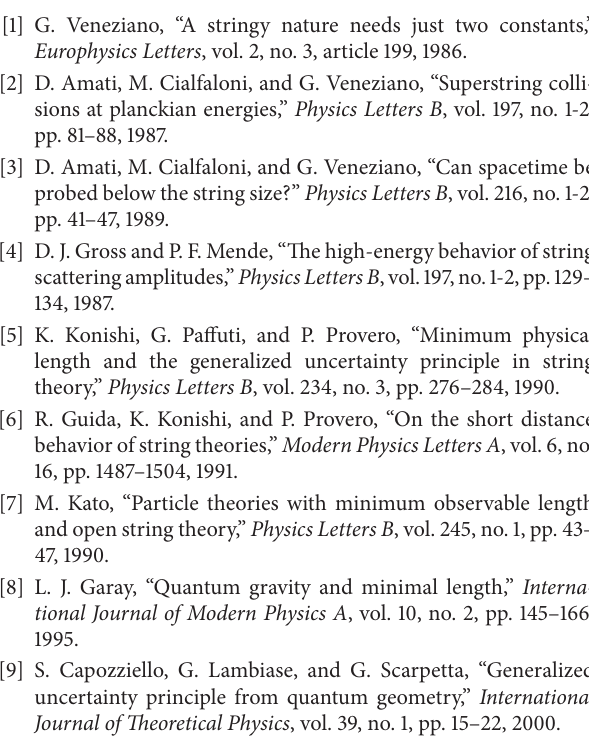
for different values of 𝛽 CORR